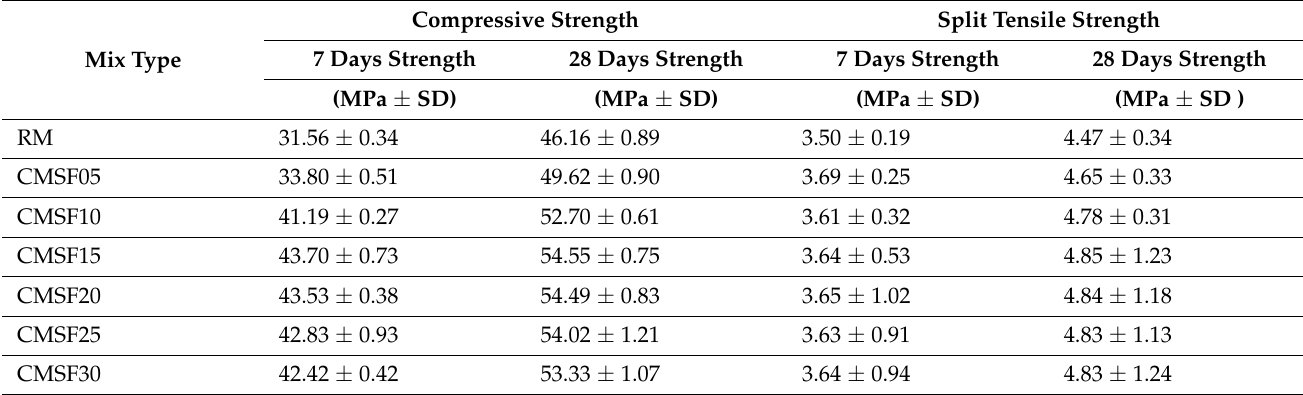
Table 4. Mechanical properties of the Different Concrete Mixes in Presence of